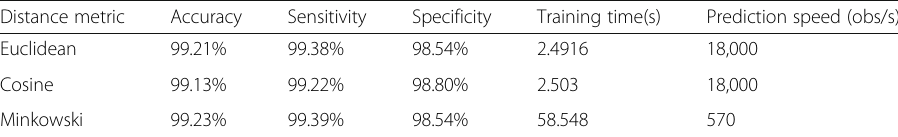
Table 1 Performances of KNN with Euclidean, Cosine, and Minkowski distance metrics Distance metric